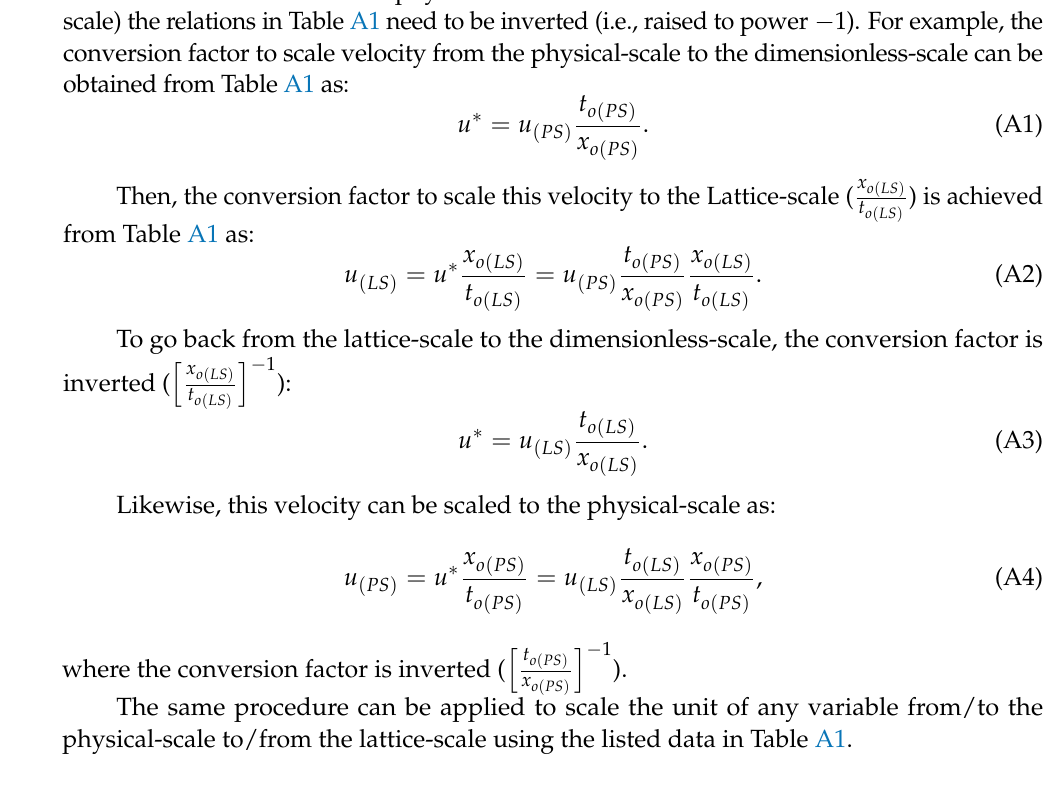
Table A1. Factors to transform some selected quantities from/to the physical-scale to/from the dimensionless-scale to/from the lattice-scale. Quantity SI Unit Dimensions